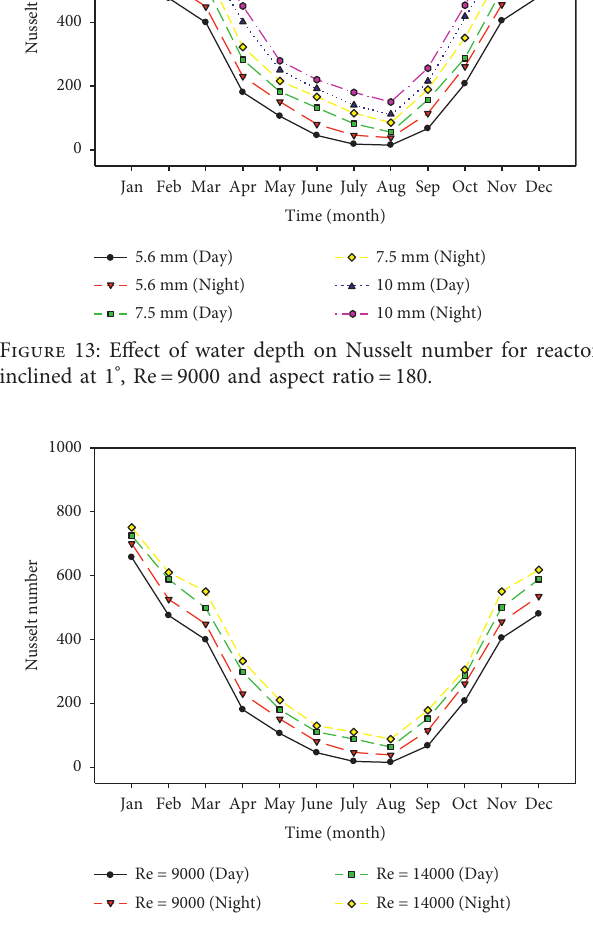
Figure 14: Effect of Re on Nusselt number for reactor inclined at 1 ° , water depth � 5.6mm and aspect ratio �